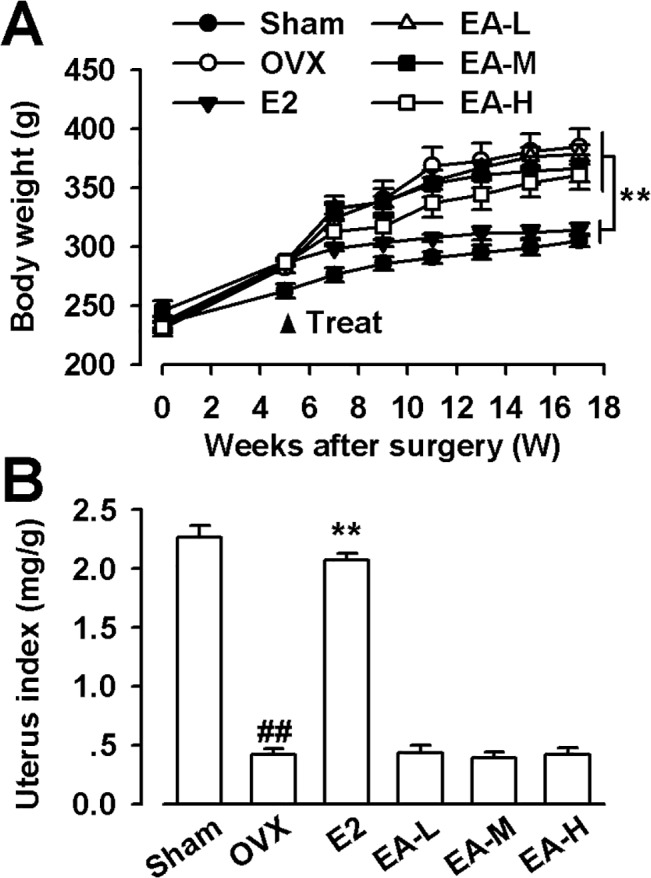
Effects of EA on body weight and uterus index.
(A) Effects of E2 and EA on body weight. (B) The uterus index was represented as uterus weight divided by body weight. E2 (25 μg/kg/day); EA-L (1 mg/kg/day); EA-M (5 mg/kg/day); EA-H (15 mg/kg/day). n = 10; ** p < 0.01 vs OVX; ##
p < 0.01 vs Sham.